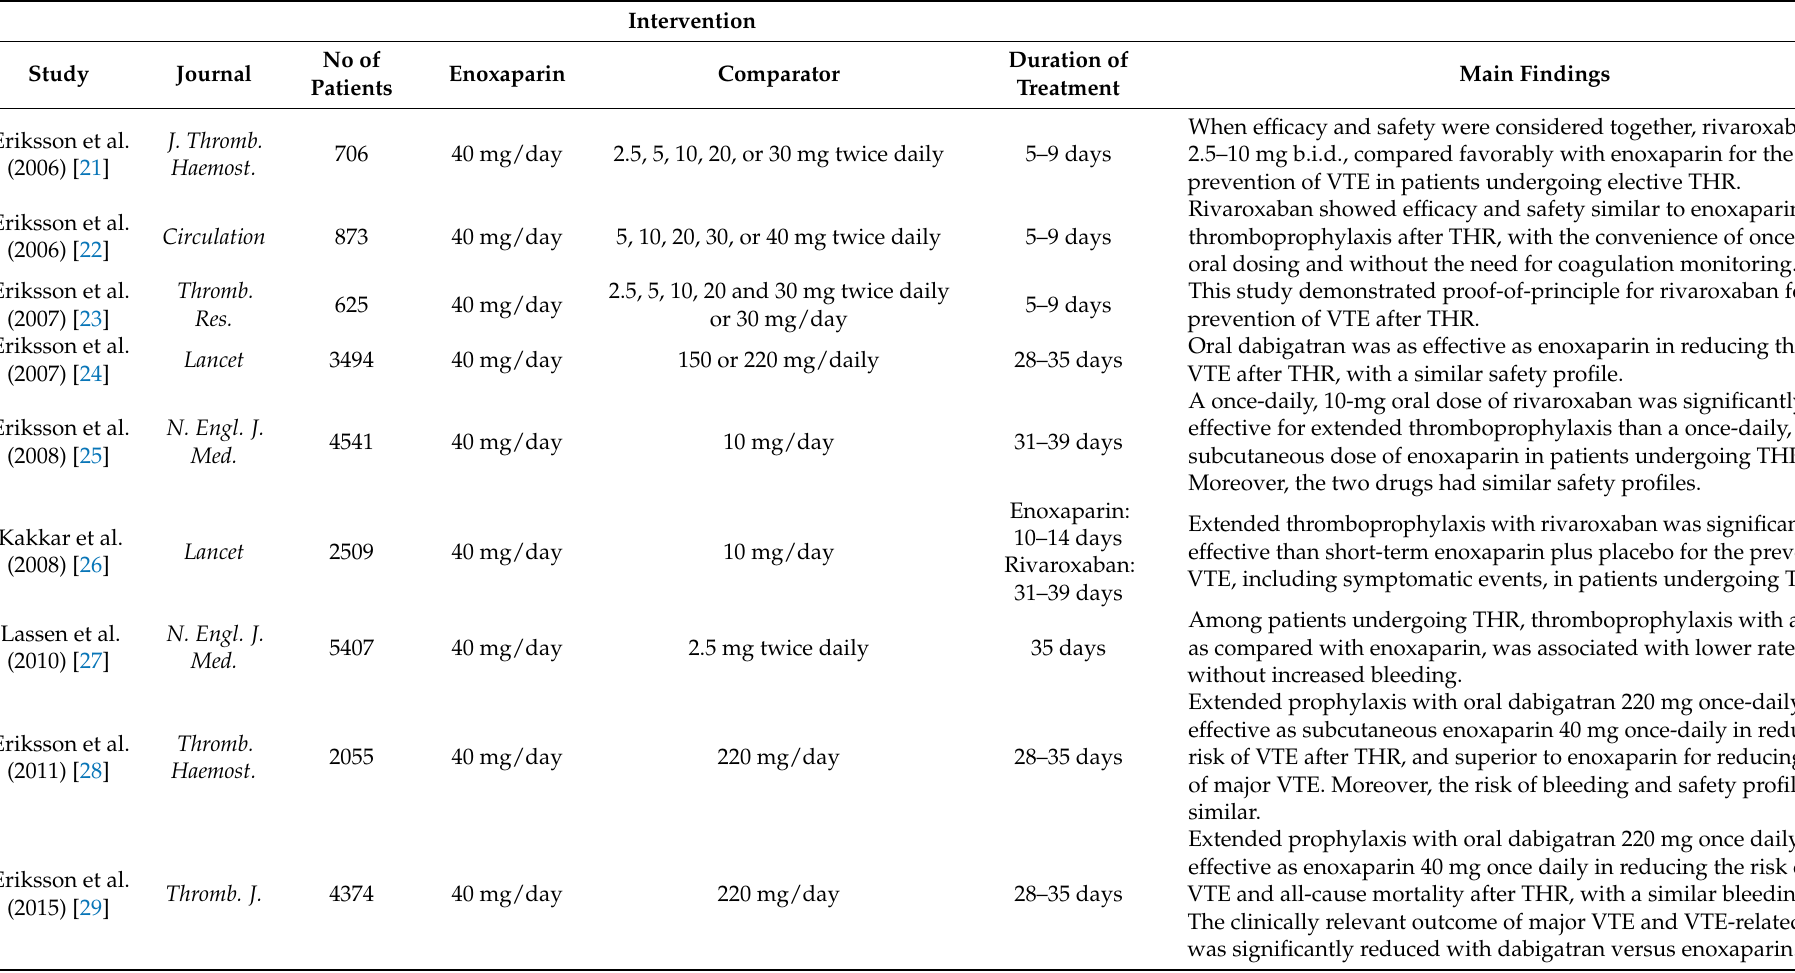
Table 1. Main characteristics of the included